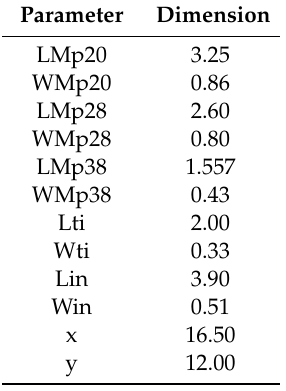
Table 2. Tri-Band Antenna’s